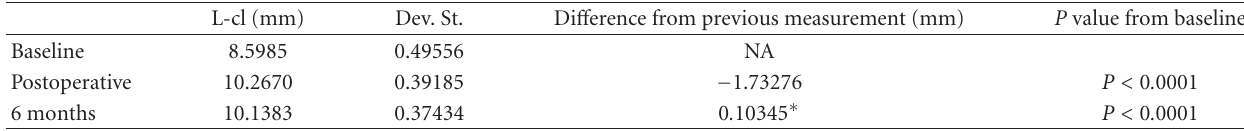
Table 1: Values of clinical crown length (L-cl) at patient level.